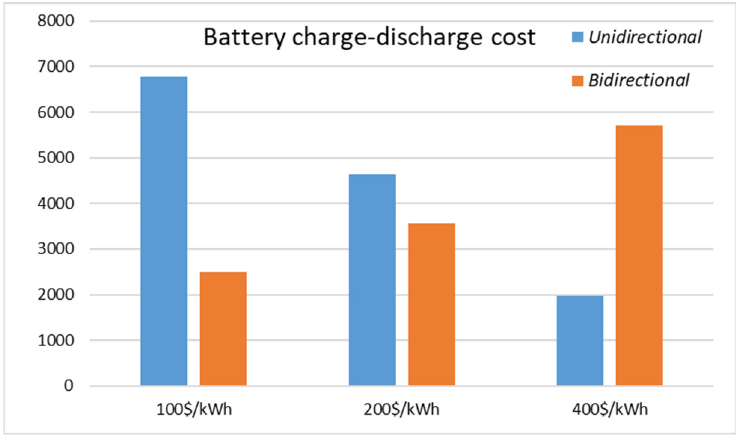
Figure 9. The cost of charging and discharging the battery.